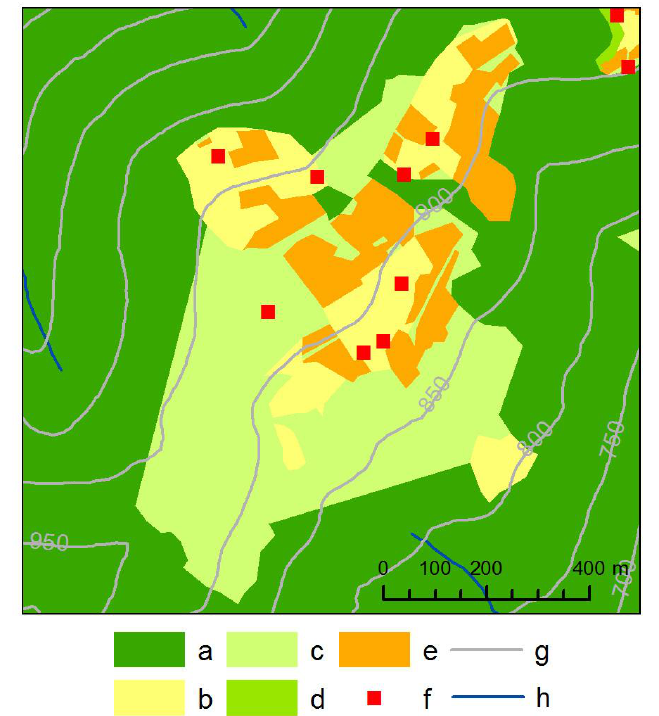
Fig. 3. Land use on Hala Jaworzyna (the Wiślańskie mountain range) in 1848 (source: author’s own elaboration on the basis of Austrian cadastral maps)